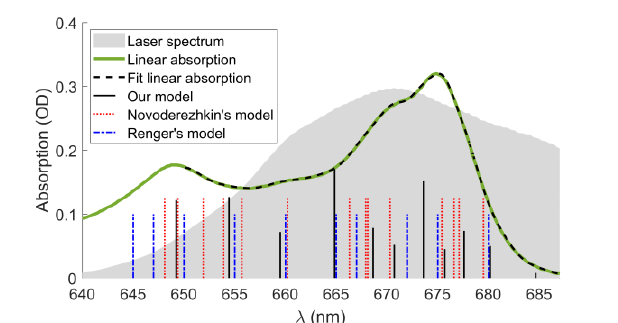
Fig. 1. Linear absorption spectrum of LHCII at 77 K overlaid with the fitted result (dash thick line). The excitation laser spectrum is shown with the shaded area. The vertical lines represent exciton energy levels obtained from our model (solid lines), from work by Novoderezhkin et. al [4] (dotted lines) and Renger et al. [5] (dash-dotted lines). The heights of the lines representing our model are proportional to the square of the corresponding transition dipole moments. The states at 649 nm and 684 nm are added to fit the linear spectrum and not included in the